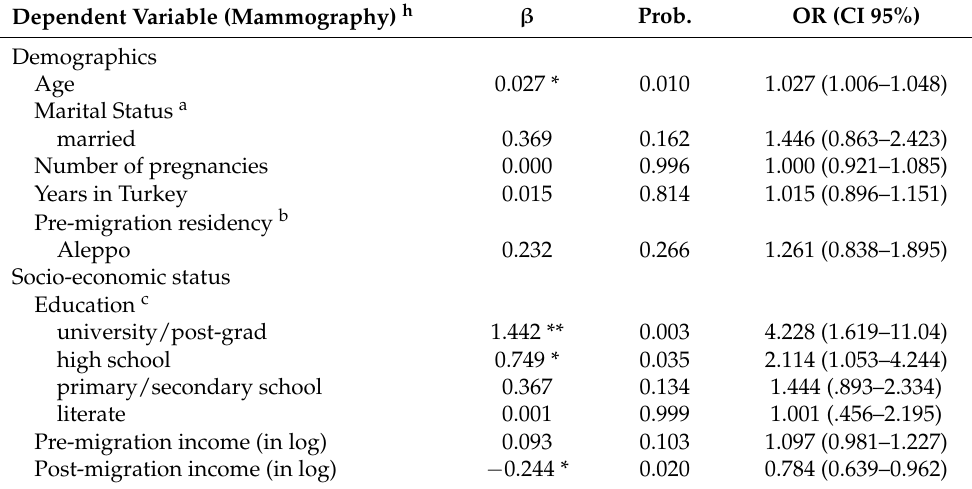
Table 3. Logistic regression